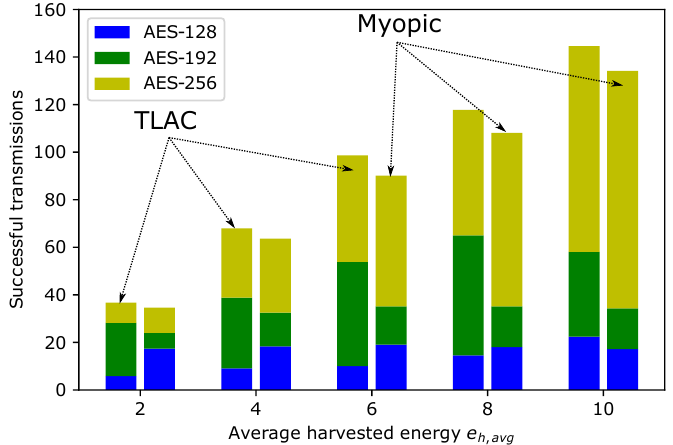
Figure 17. Comparison between the proposed TLAC and the myopic schemes, based on harvested energy.